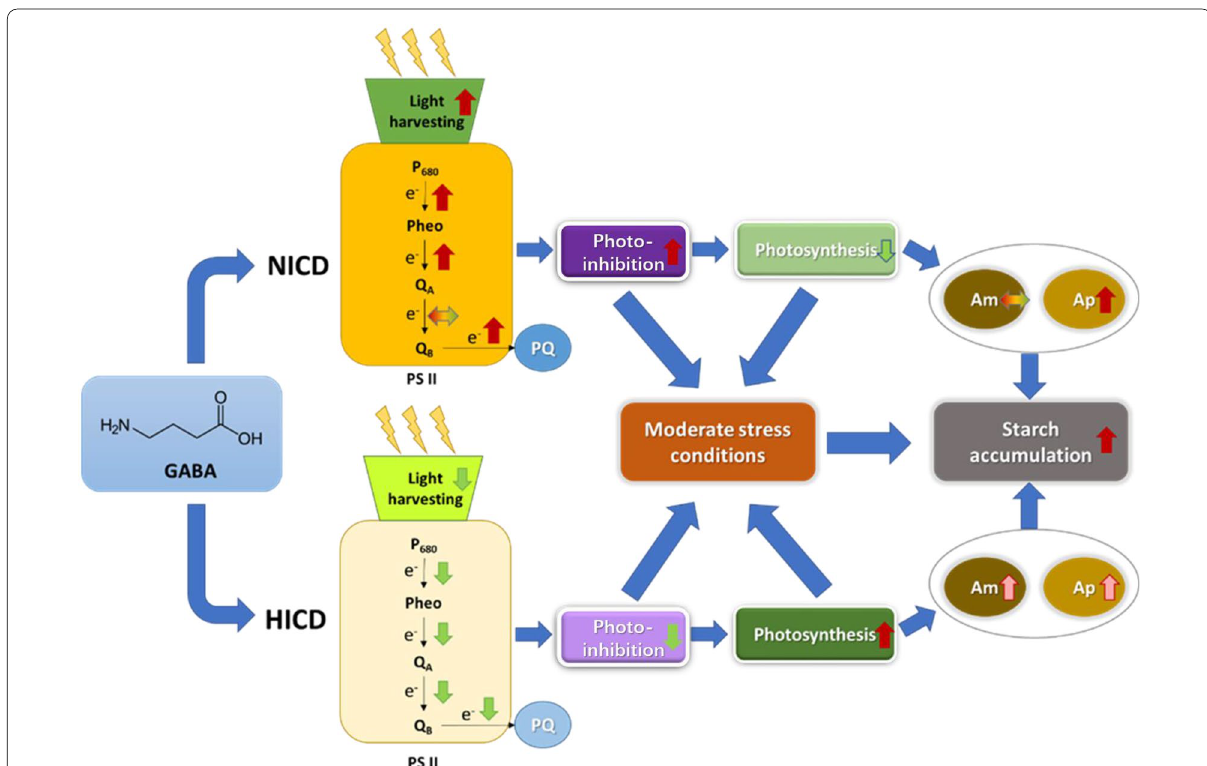
Fig. 4 Summary of the different effects of GABA on the photosynthetic physiology, stress regulation, and starch accumulation in T. subcordiformis exposed to nitrogen deprivation under NICD and HICD conditions. The summary was based on the results obtained on Day 4 under NICD with 0 vs. 5 mM GABA and HICD with 0 vs. 2.5 mM GABA which showed maximum starch production improvements,